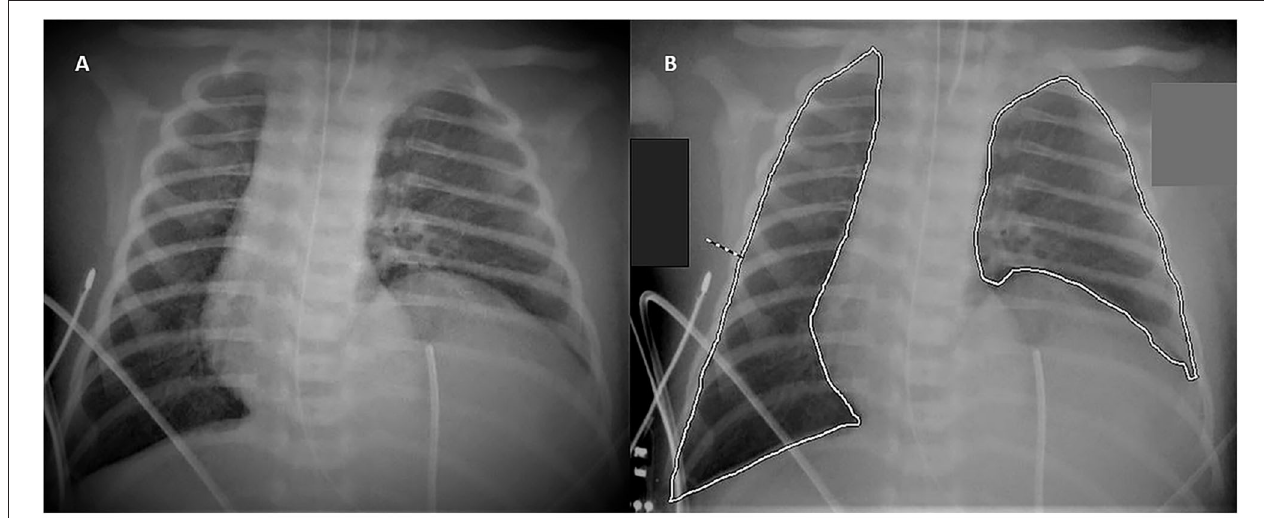
FIGURE 1 | Tracing Method. The figure shows the method to calculate the area of the lungs: chest radiograph of a 1-day-old infant without (A) and with (B) the freehand tracing of the perimeter of the lungs.